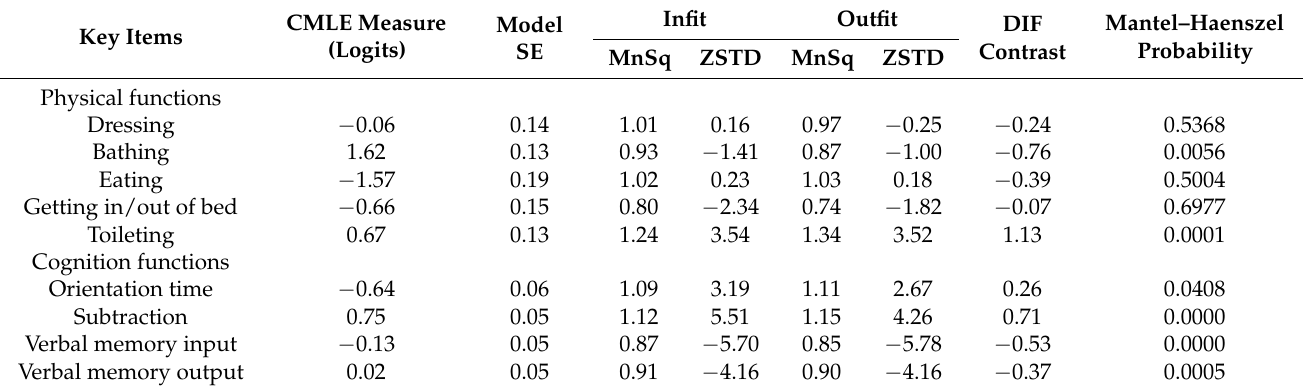
Table 3. ADL and IADL function items in the 2011 CHARLS, 2011 JSTAR, and 2010